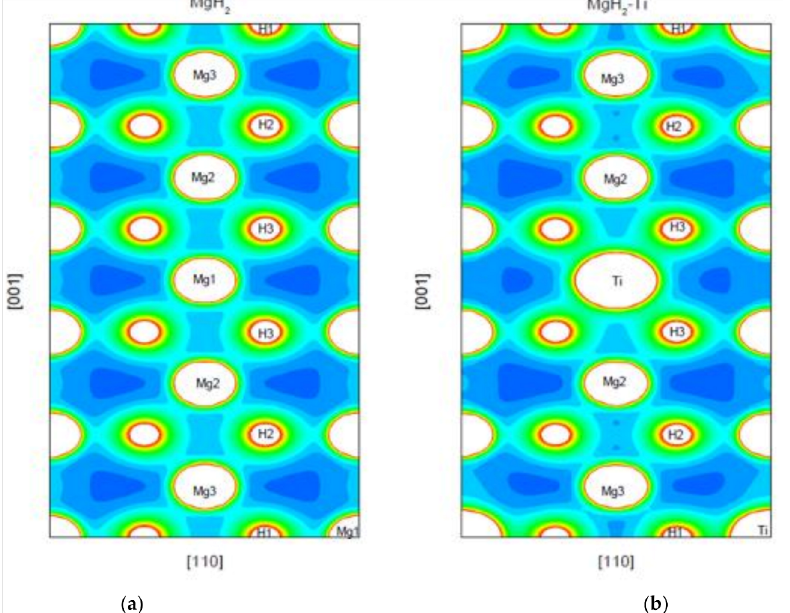
Figure 11. Charge distribution on the (110) plane of the ( a ) MgH 2 and ( b ) MgH 2 –Ti. The sym- metrically nonequivalent atoms are denoted by numbers 1–3, respectively. ( a , b ) Reproduced with permission [195]. Copyright 2003,